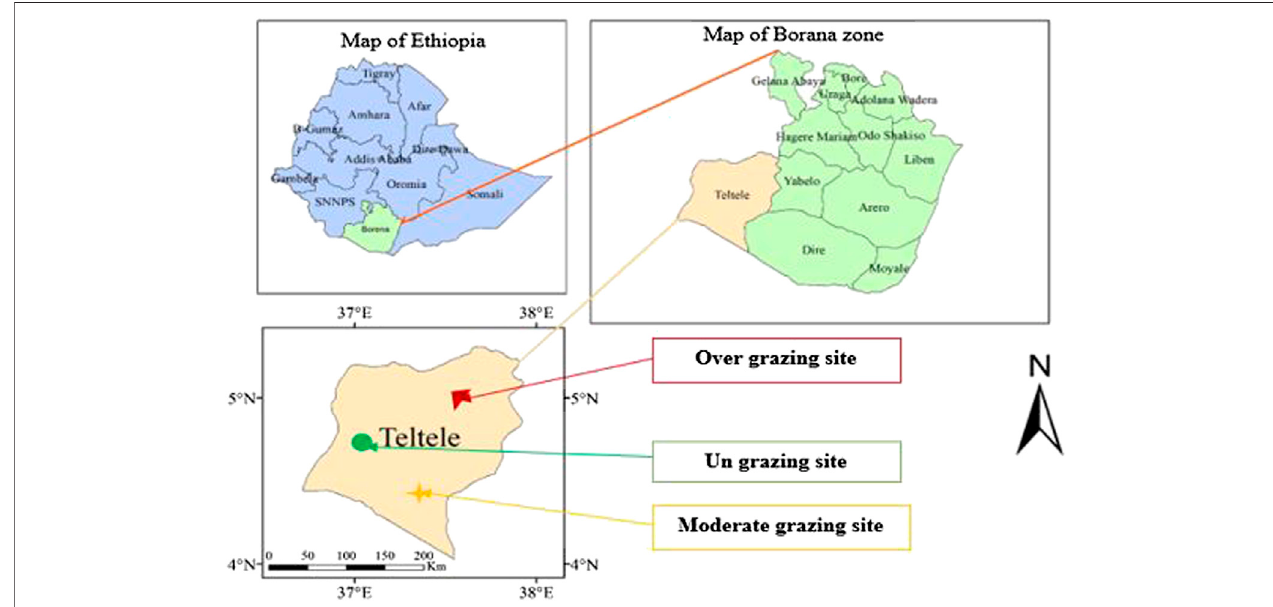
FIGURE 1 | Location map of the study